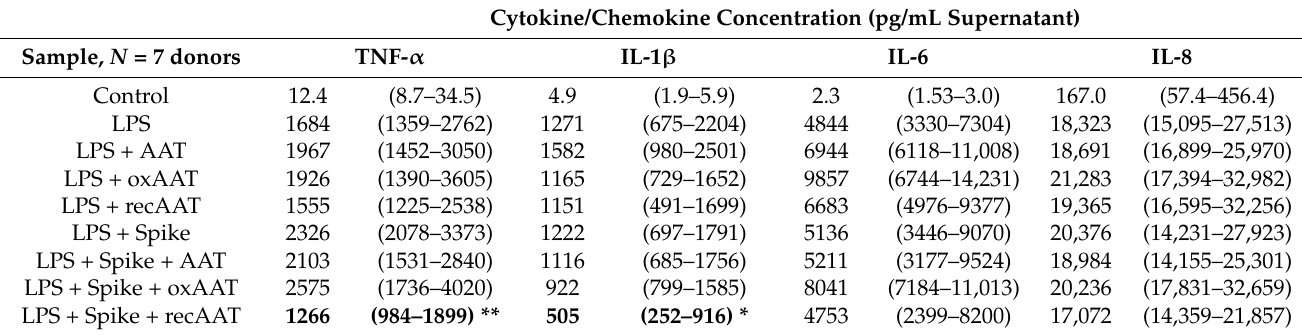
Table 2. Cytokine/chemokine release in supernatants after PBMCs culture for 6 h. Cytokine/Chemokine Concentration (pg/mL